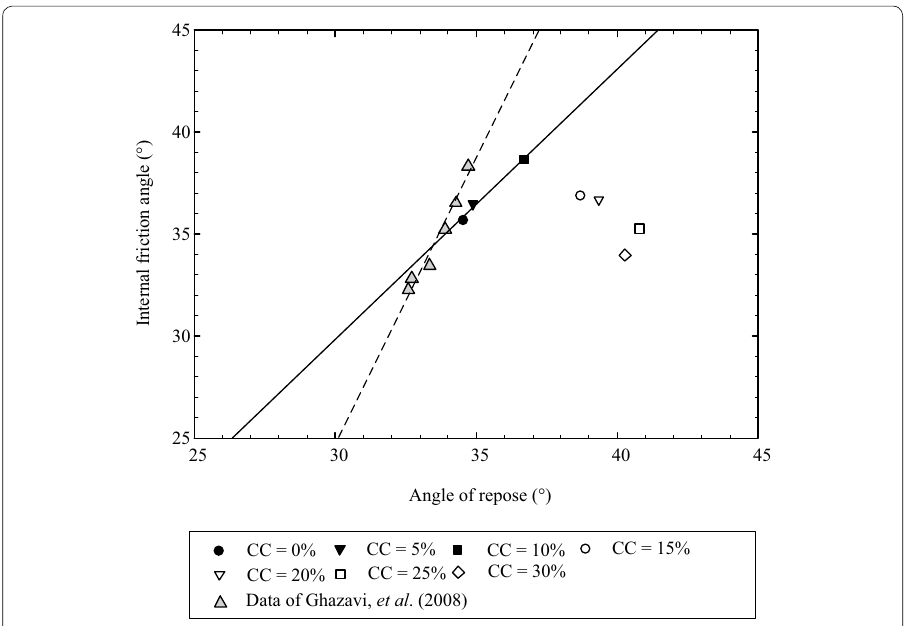
Fig. 8 Relationship between angle of repose and internal friction angle